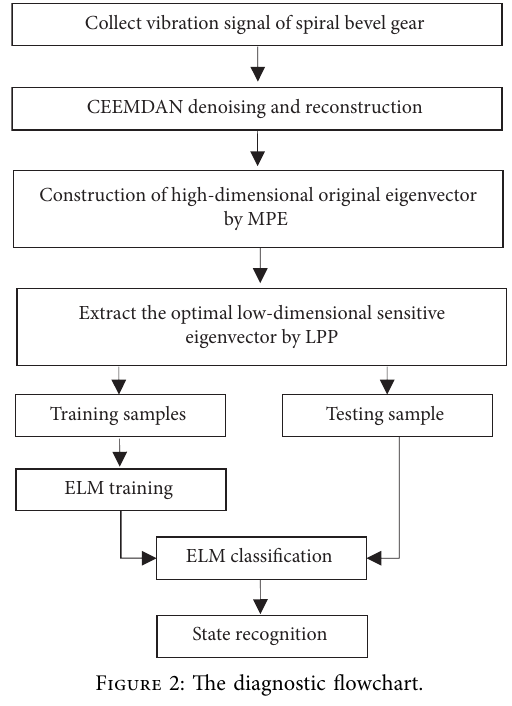
Figure 2: The diagnostic